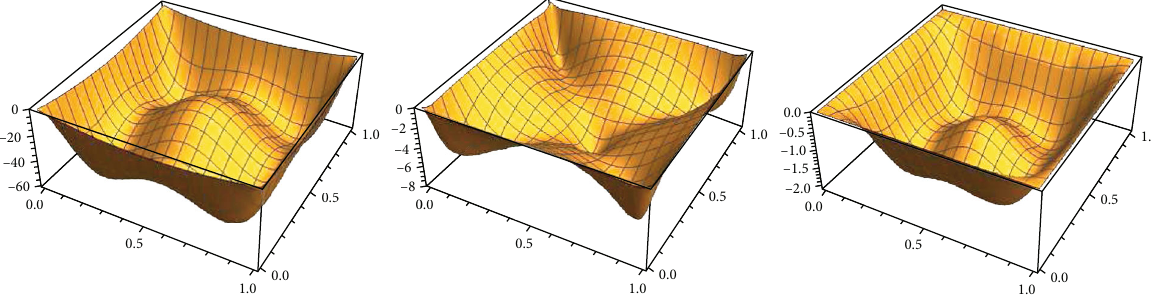
= μ / ð 2 β Þ , and the variational functional m 0 0